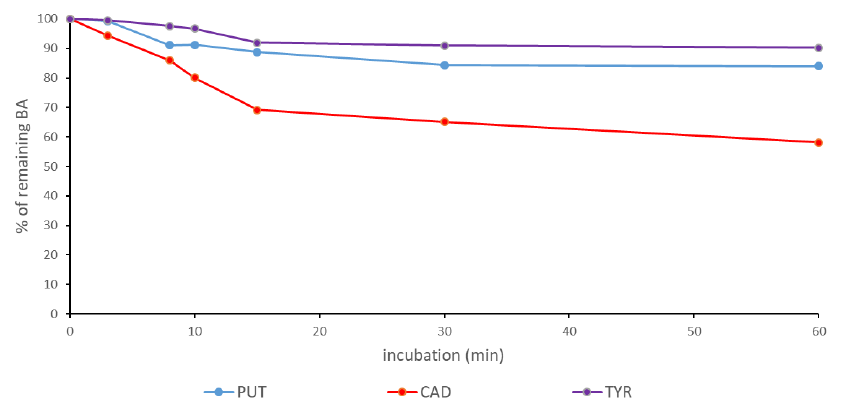
Figure 5. Degradation of biogenic amines (BA) (putrescine—PUT; cadaverine—CAD; tyramine— TYR) by diamine oxidase from fenugreek sprouts in the dough during kneading (0–15 min) and resting (15–60 min).